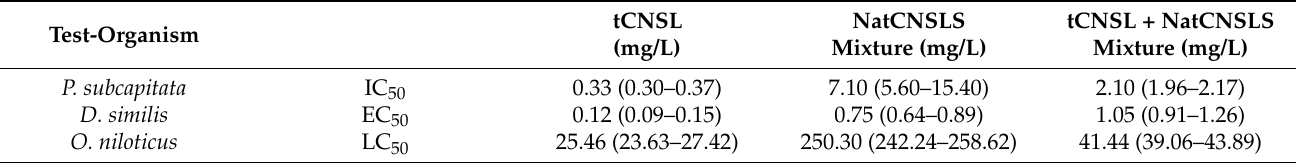
Table 1. The tCNSL, NatCNSLS mixture and tCNSL + NatCNSLS mixture Inhibitory (IC), effective (EC) and lethal (LC) concentrations 50% obtained with the three test-organisms used. In brackets the 95% confidence intervals.